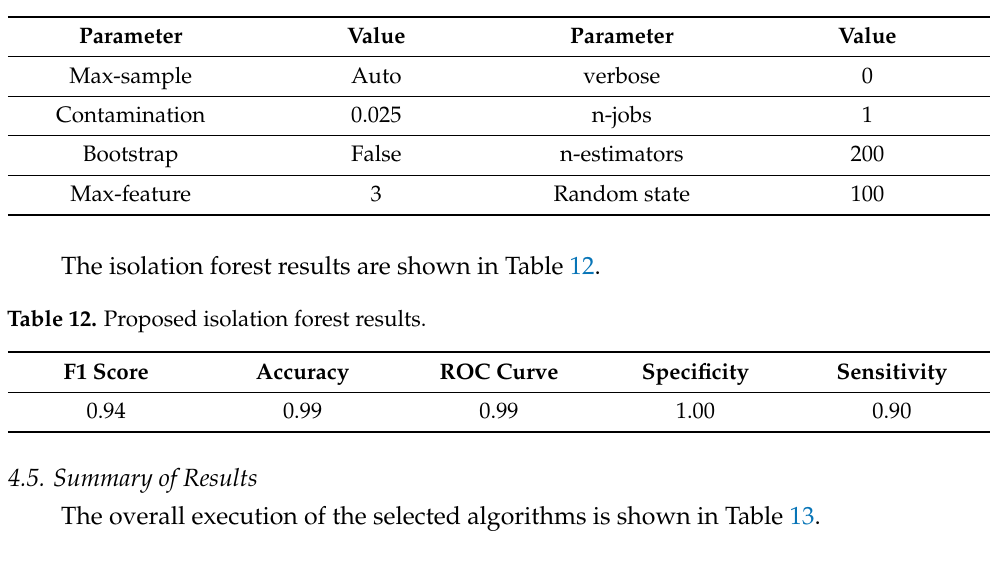
Table 11. Values of used implementation parameters.